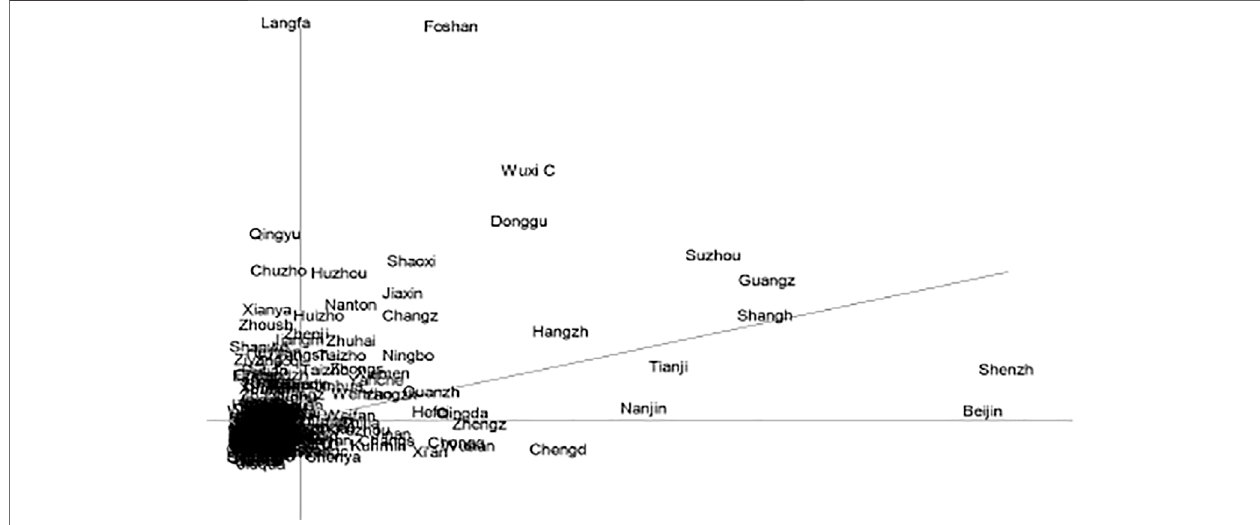
FIGURE 2 | The Moran Index of the total number of green patents in